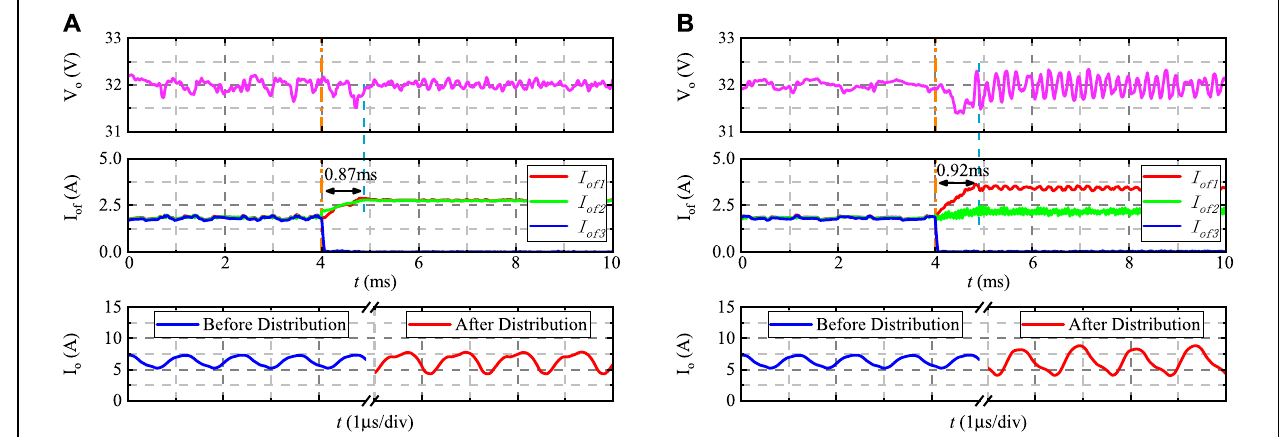
FIGURE 14 | Experimental waveforms of the load distribution scheme switching at 70-W: (A) each of the two phases outputing 50% of the power, (B) one phase outputing 60% of the power, and the other phase outputing